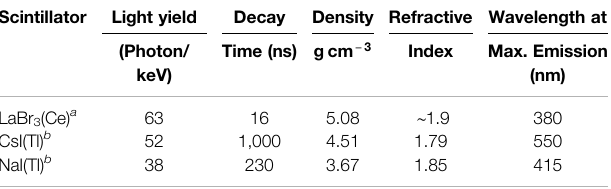
TABLE 1 | Properties of most common scintillator materials for gamma-ray